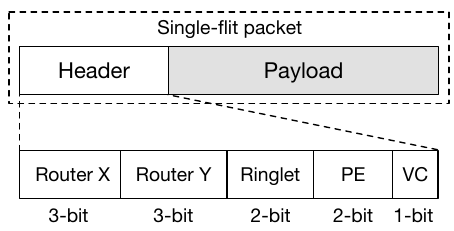
Figure 4. Structure of the single-flit